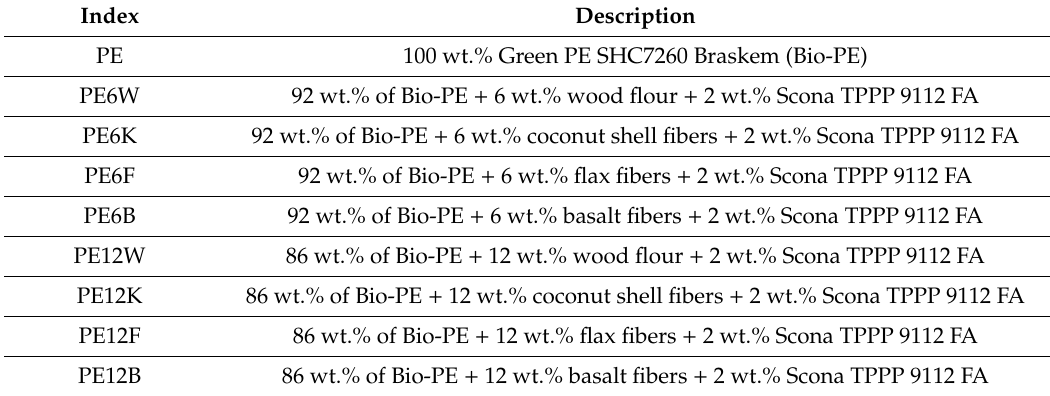
Table 1. Description of tested